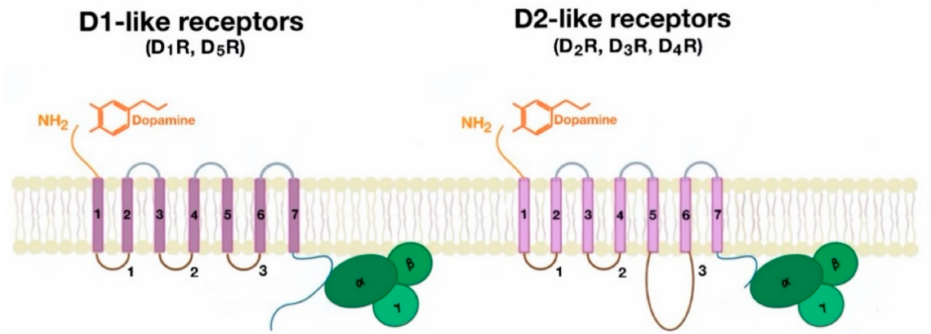
Figure 10. Structural di ff erences between D1-like receptor (left side of picture) and D2-like receptors (right side of